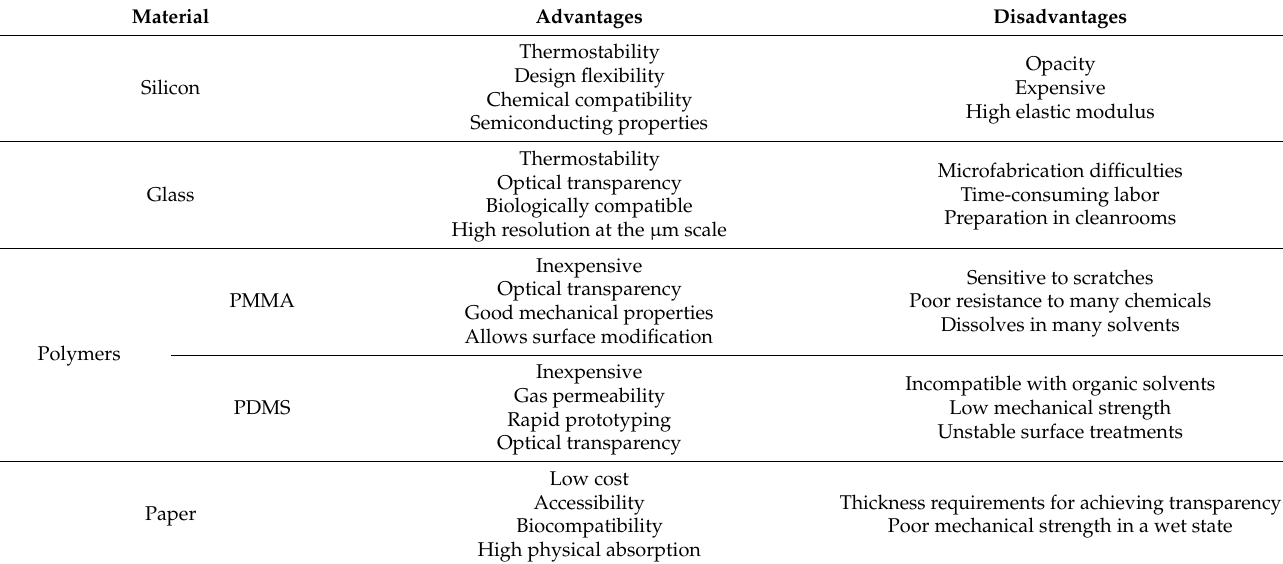
Table 3. Summary of the advantages and disadvantages of the different materials used in the fabrication of microfluidic structures and